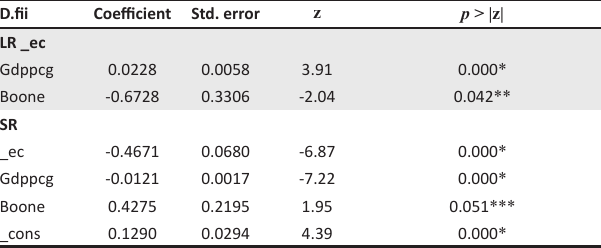
TABLE 4: Results of the cointegration test. No of CEs